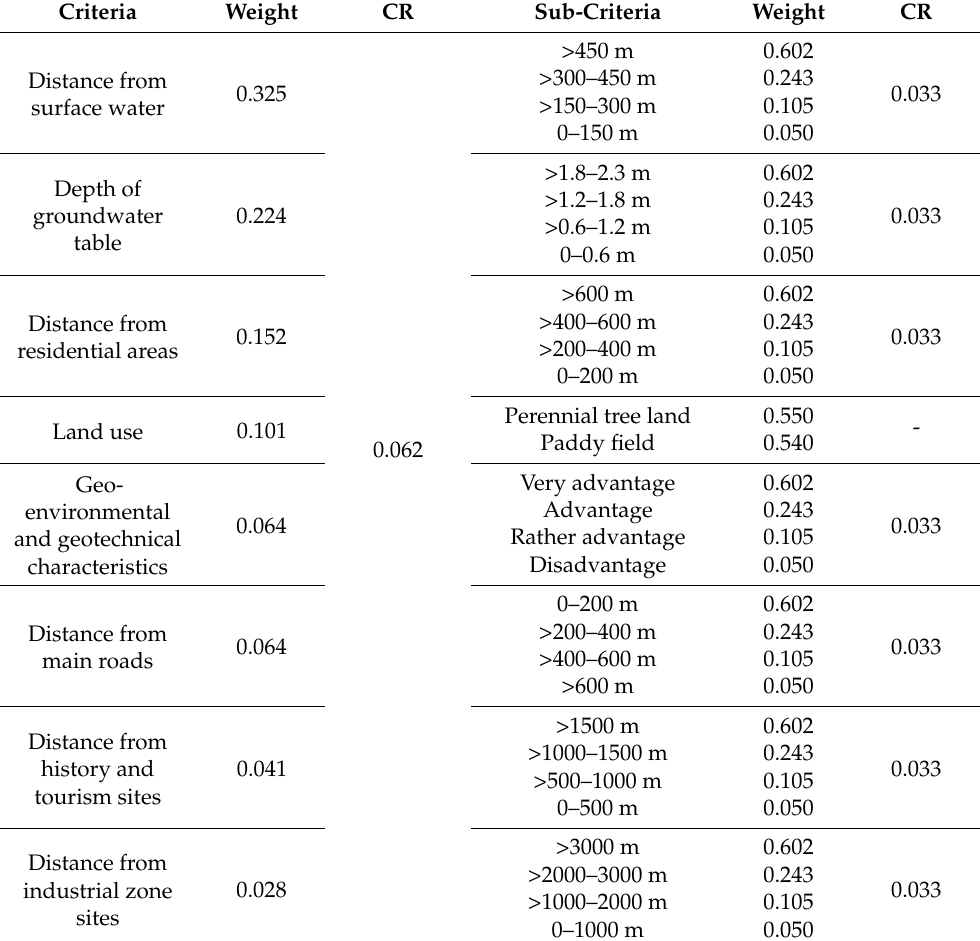
Table 5. Weights of criteria and